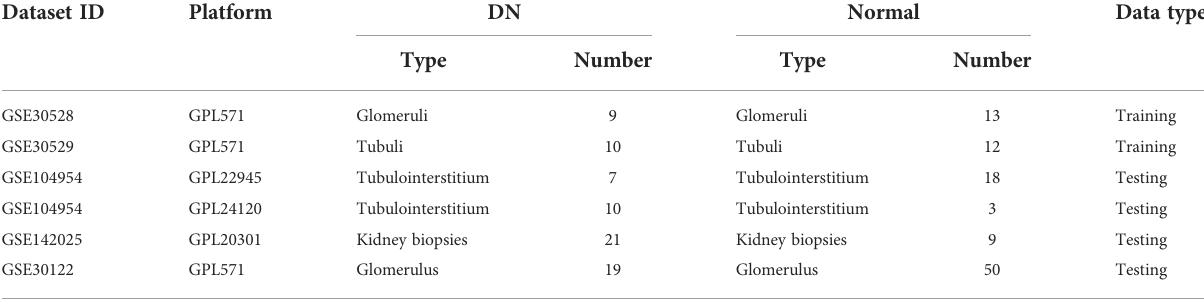
TABLE 1 The microarray dataset information.